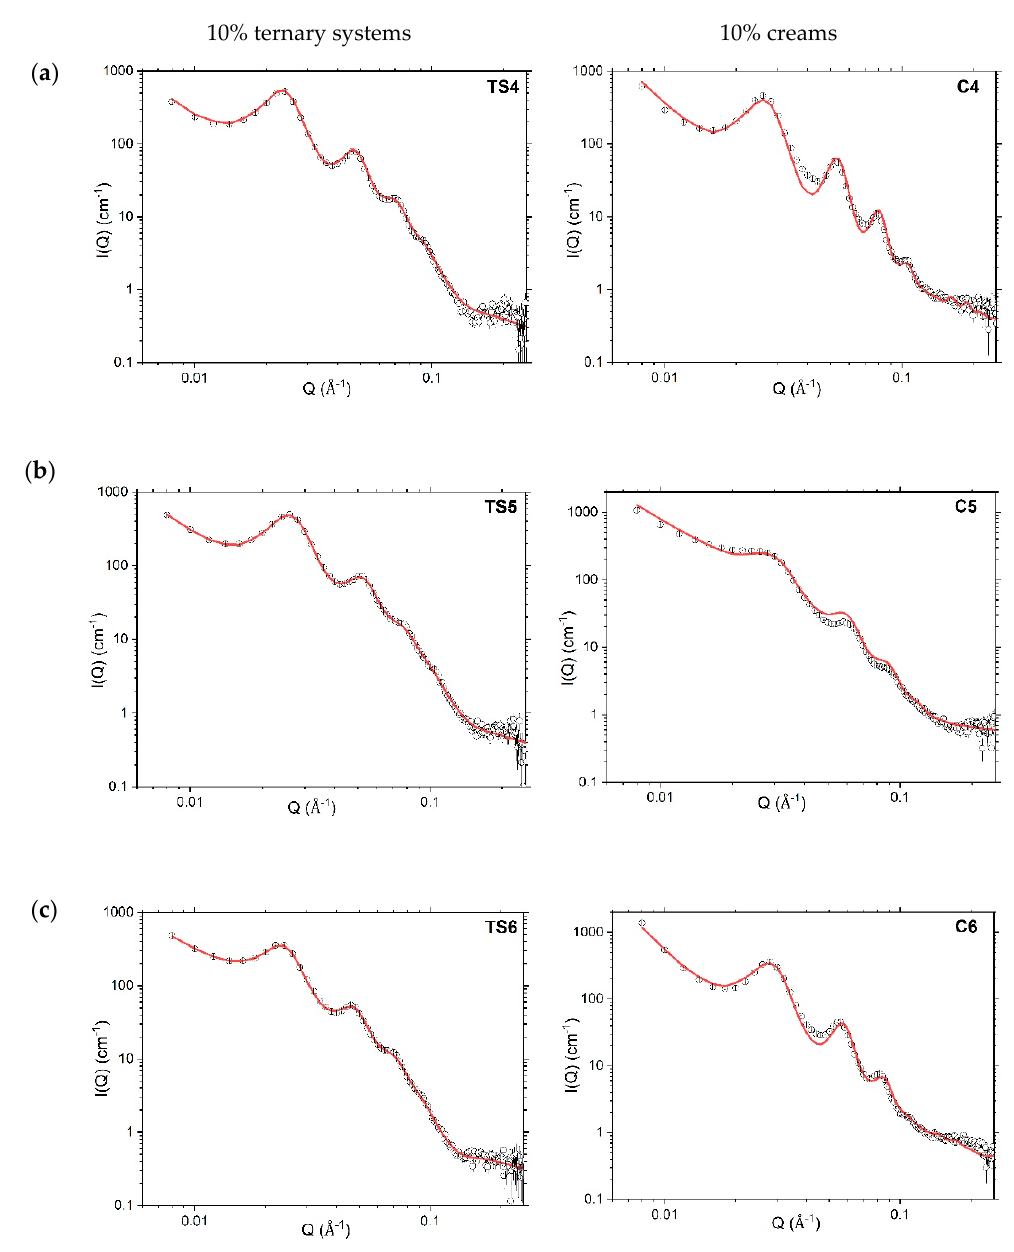
Figure 4. Model-fitted SANS profiles (red lines) recorded at 298 K for 10% ternary systems (TS; left) (Model A1) and creams ( c ; right) (Model A2) prepared with a 1:1 ( a ), 1:0 ( b ) or 0:1 ( c ) ratio of hexadecanol:octadecanol co-surfactants. Error bars on the measured data are subsumed within the plotted symbols. Formulation compositions are provided in Methods, Table 1.